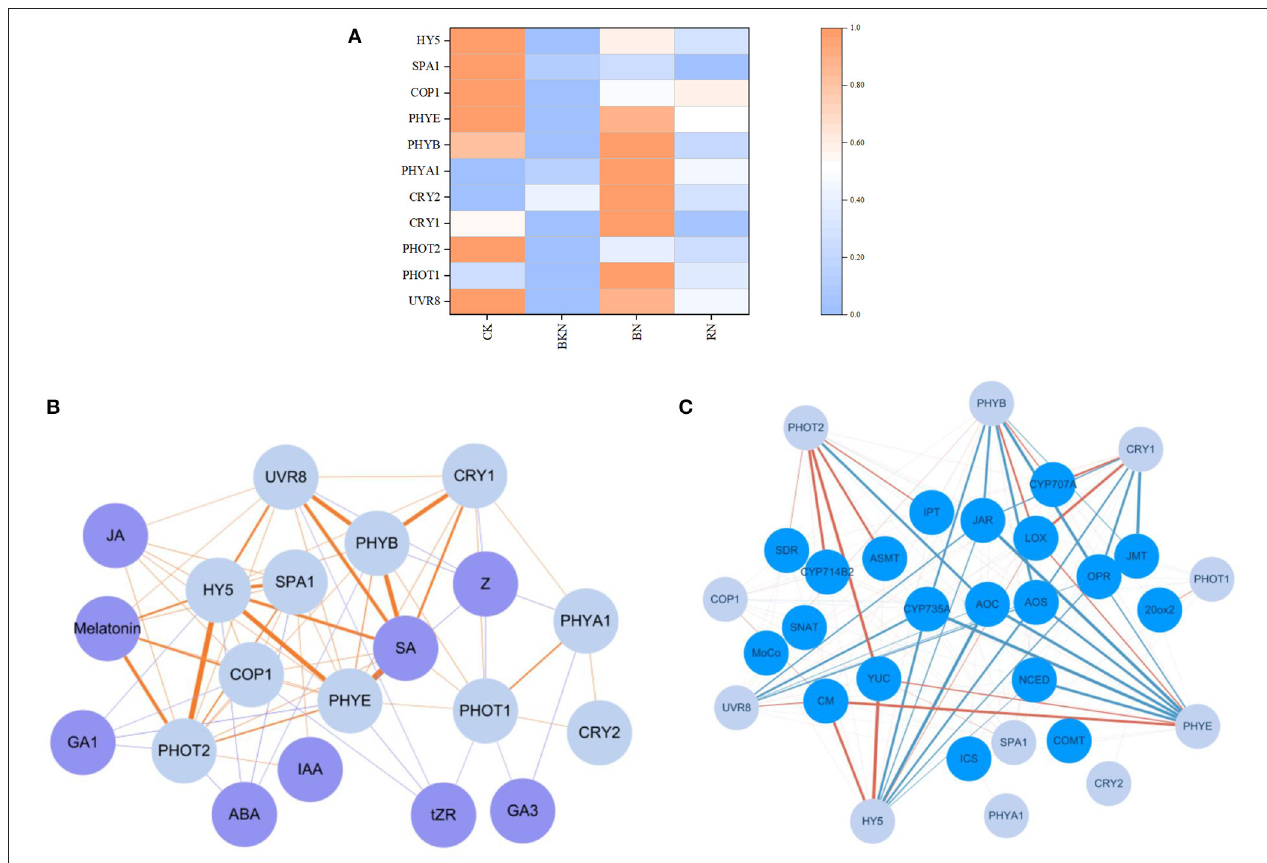
FIGURE 4 | The effects of different shading treatments on the expressions of light signal and phytohormone biosynthesis-related genes in tea leaves. (A) The heatmap of light signal-related genes, (B) the correlation network of light signal-related genes (light blue nodes) and phytohormone levels (purple nodes), and (C) the correlation network of light signal-related genes (light blue nodes) and phytohormone biosynthetic genes (blue nodes). The co-expression networks of the FPKM values of light signal perception and signaling genes (PHYB, PHYE, PHOT1, CRY1, CRY2, UVR8, COP1, SPA1, and HY5) and the phytohormone contents (ABA, GA1, GA3, IAA, JA, melatonin, SA, tZR, and Z), as well as the FPKM values of light signal perception and signaling genes (PHYB, PHYE, PHOT1, CRY1, CRY2, UVR8, COP1, SPA1, and HY5) and the phytohormone biosynthetic genes (CM, ICS, YUC, IPT, CYP735A, CYP714B2, NCED, SDR, MoCo, CYP707A, SNAT, ASMT, COMT, 20ox2, LOX, AOS, AOC, OPR, JAR, and JMT), were conducted using the Cytoscape software (version 3.8.0). Significant correlation was presented based on the statistical test with a robust cutoff ( p < 0.05). The orange color lines represented positive correlation and the blue color lines represented negative correlation. The correlation coefficient increased from 0.80 to 0.99 as the line color deepened. HY5, Elongated hypocotyl 5; SPA1, suppressor of PHYA; COP1:constitutive photomorphogenesis 1; PHYs, phytochromes; CRYs, cryptochromes; UVR8, UV resistance locus 8; ABA, abscisic acid; GA1, gibberellin A1; GA3, gibberellin A3; IAA, indole-3-acetic acid; JA, jasmonic acid; SA, salicylic acid; tZR, trans -zeatin-riboside; Z, zeatin; CM, chorismate mutase; ICS, isochorismate synthase; YUC, indole-3-pyruvate monooxygenase; IPT, adenylate isopentenyltransferase; CYP735A, cytokinin hydroxylase; CYP714B2, cytochrome P450 714B2; NCED, 9- cis -epoxycarotenoid dioxygenase; SDR, short chain dehydrogenase/reductase; MoCo, molybdenum cofactor; CYP707A, abscisic acid 8 ′ -hydroxylase CYP707A; SNAT, serotonin-N-acetyltransferase; ASMT, N-acetylserotonin methyltransferase; COMT, caffeic acid- O -methyltransferase; 20ox2, gibberellin 20; LOX, lipoxygenase; AOS, allene oxide synthase; AOC, allene oxide cyclase; OPR, 12-oxophytodienoate reductase; JAR, jasmonoyl-L-amino acid synthetase; JMT; jasmonate O -methyltransferase; CK, tea sample grown in nature light; BKN, black net shade-treated sample; BN, blue net shade-treated sample; RN, red net shade-treated sample. Each cell represents the mean value of 3